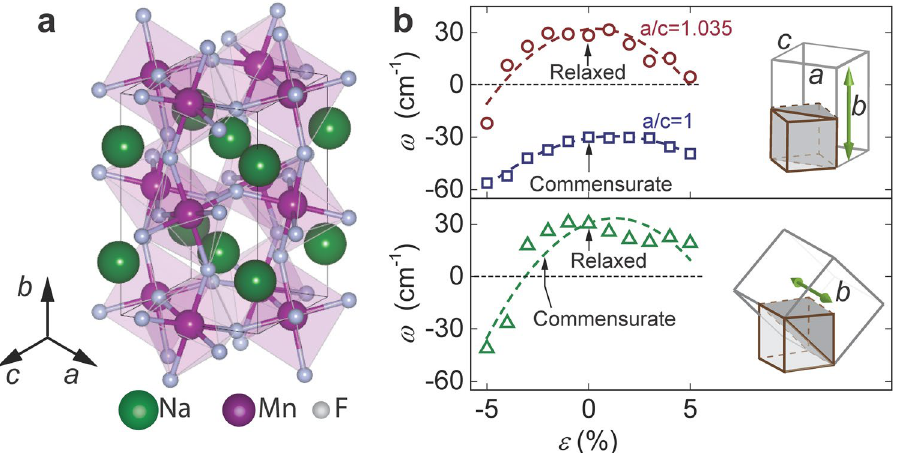
Figure 1. Ferroelectricity depending on growth and strain configurations. ( a ) Schematic of NaMnF 3 unit cell 21 . ( b ) Polar mode frequency as functions of isotropic strain in the plane parallel to SrTiO 3 (001) surface when NaMnF 3 is grown with b-axis out-of-plane (top, the two curves indicate different a/c ratios) or in-plane (bottom). Arrows indicate the data points corresponding to commensurate growth and completely relaxed cases. Dashed lines are added as guide for the eye. Insets illustrate the orientations of NaMnF 3 lattice relative to the cubic SrTiO 3 unit